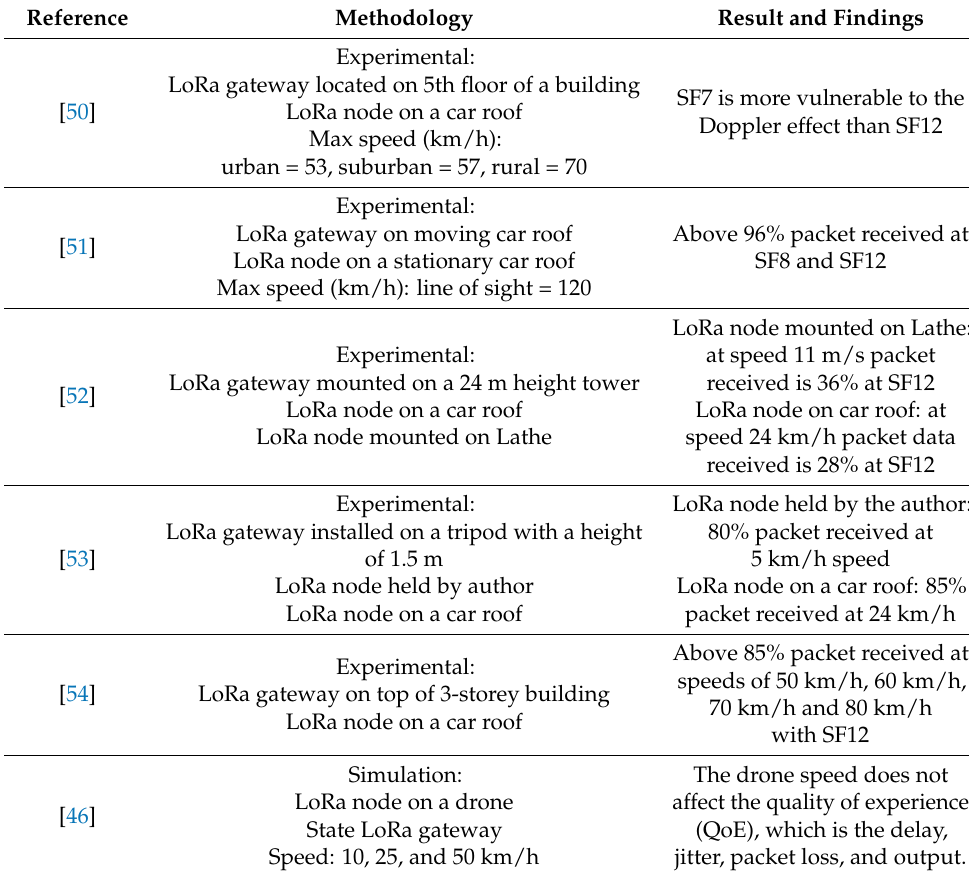
Table 2. Previous research works focusing on LoRa performance vs. Doppler